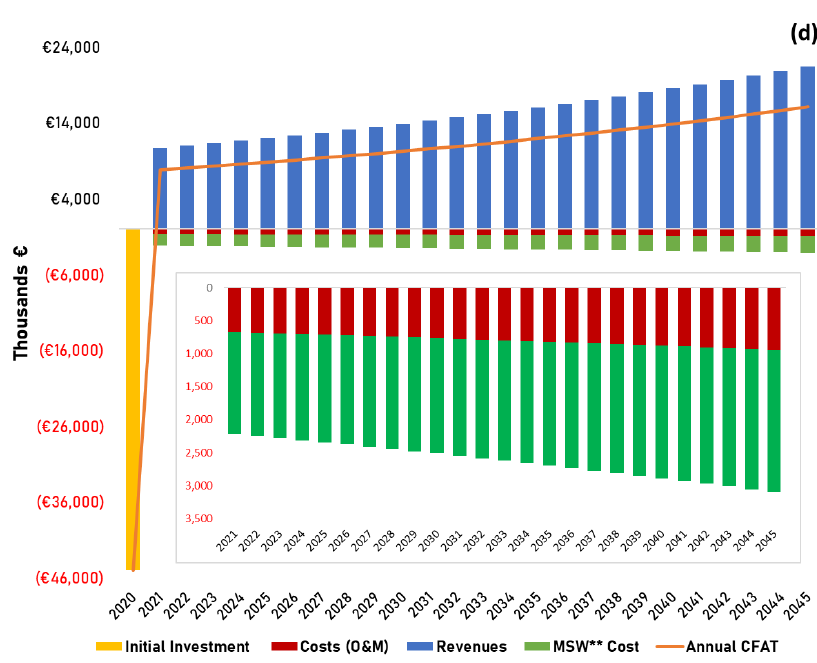
Figure 8. Cash flows concerning the various gasification projects depicting the annualized costs and revenues throughout the plant’s lifetime for Portugal with ( a ) acacia and ( b ) MSW *, and Brazil with ( c ) eucalyptus and ( d ) MSW **.